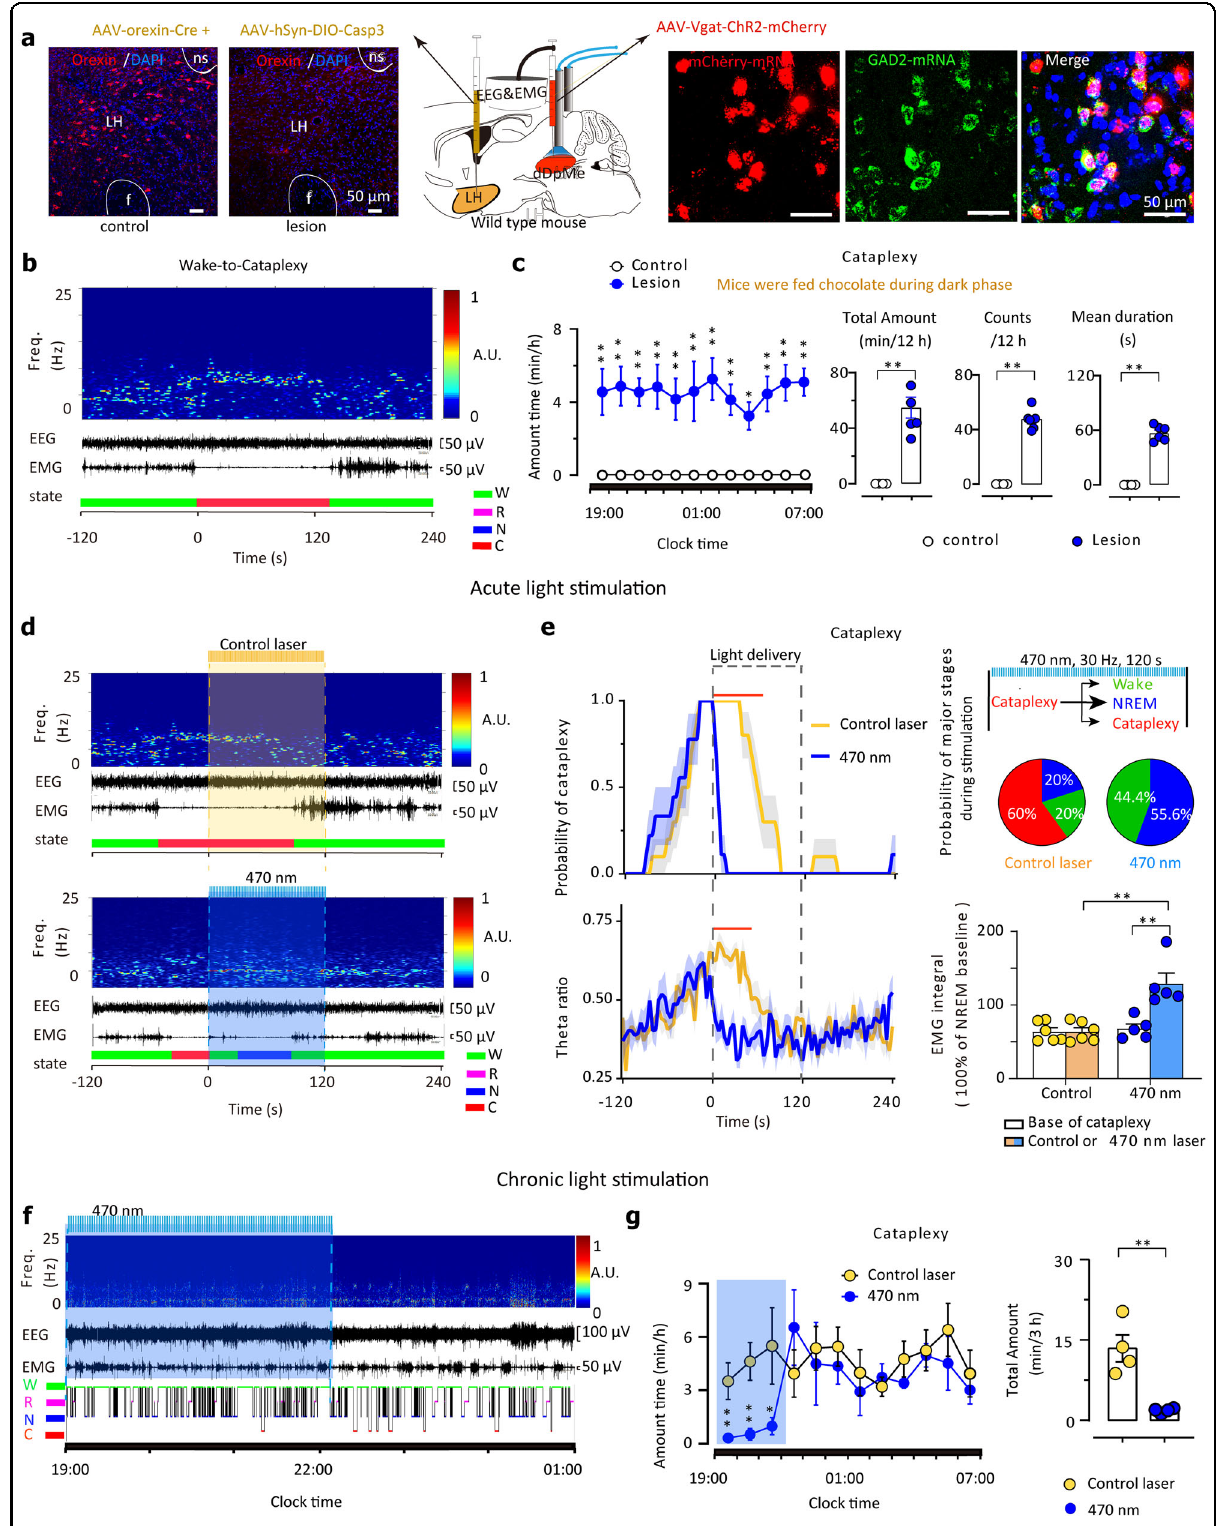
Fig. 5 (See legend on next